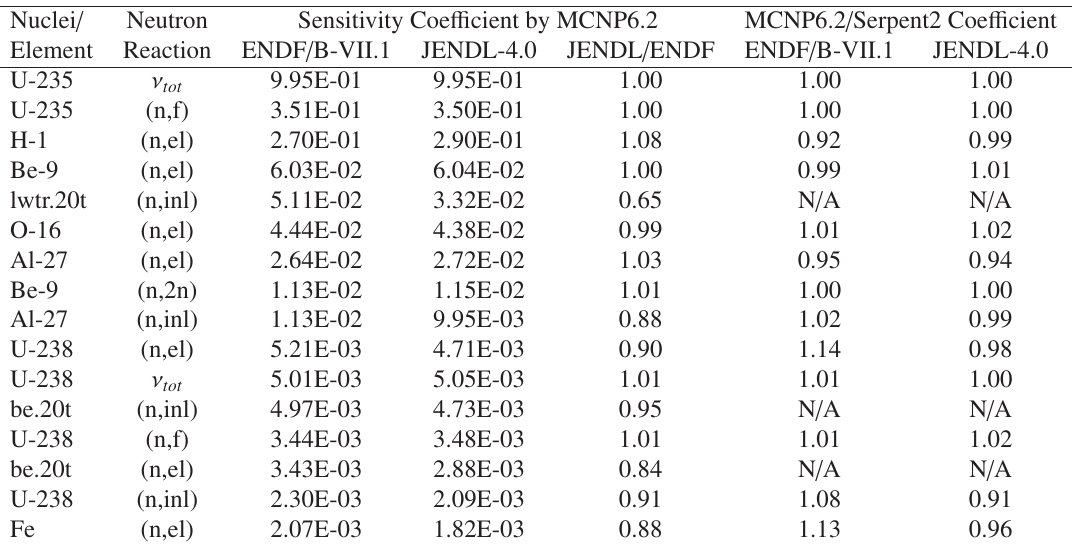
Table 4. Sensitivities of k in increasing